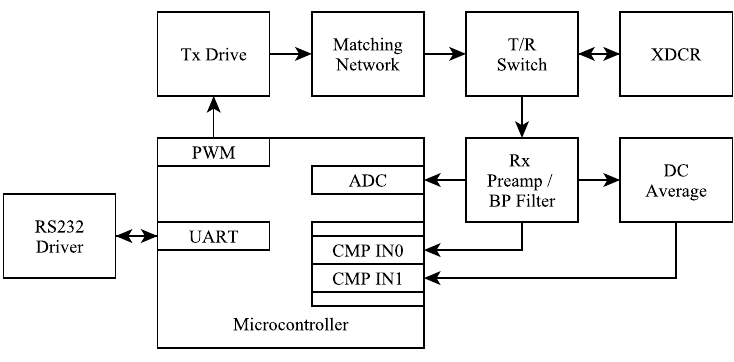
Figure 9. Block diagram for the NMv3 hardware design.